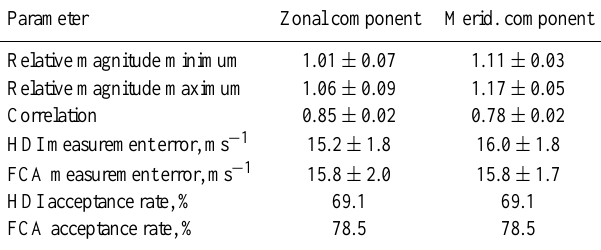
Table 7. Mean and standard deviation of daily relative magnitude minima and maxima, correlation, maximum measurement errors, and acceptance rates for HDI relative to FCA-large from 18 June 1998 to 29 June 1998. Parameter Zonal component Merid. component Relative magnitude minimum 1 . 01 ± 0 . 07 1 . 11 ± 0 . 03 Relative magnitude maximum 1 . 06 ± 0 . 09 1 . 17 ± 0 . 05 Correlation 0 . 85 ± 0 .